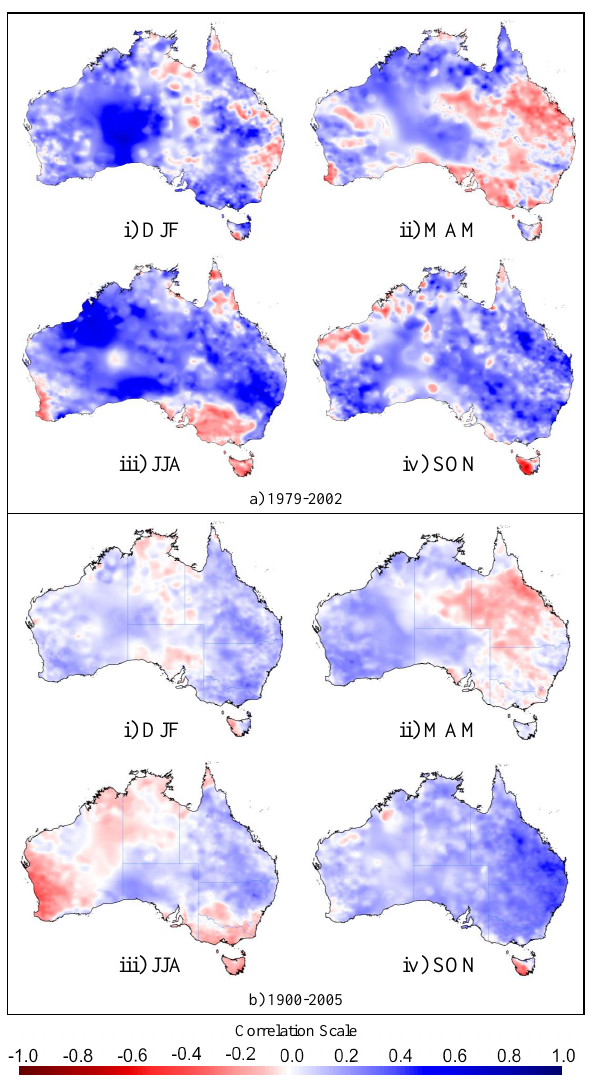
Fig. 8. Seasonal Australian rainfall correlated with Visbeck over (a) 1979–2002 and (b) 1900–2005 for (i) DJF, (ii) MAM, (iii) JJA and (iv)